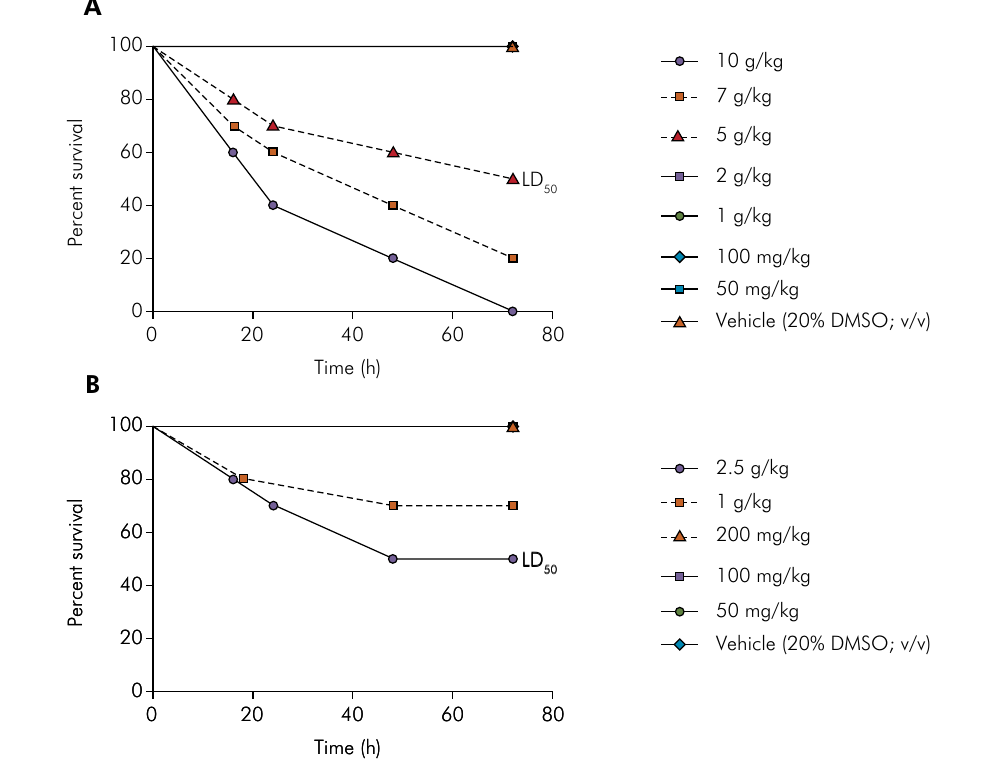
Figure 3. In vivo s ystemic toxicity of the A.colubrina, increasing doses from 50 mg/kg to 10 g/kg (A); and increasing nystatin doses from 5 mg/kg to 2.5 g/kg (B), using a G. mellonella modelo (p > 0.05, log-rank test).